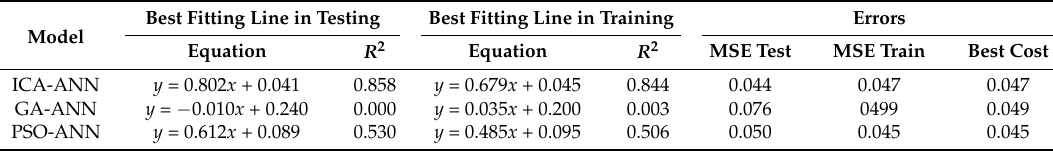
Table 7. Results of ANN models optimized by the GA, ICA, and PSO algorithms in training and testing. Model